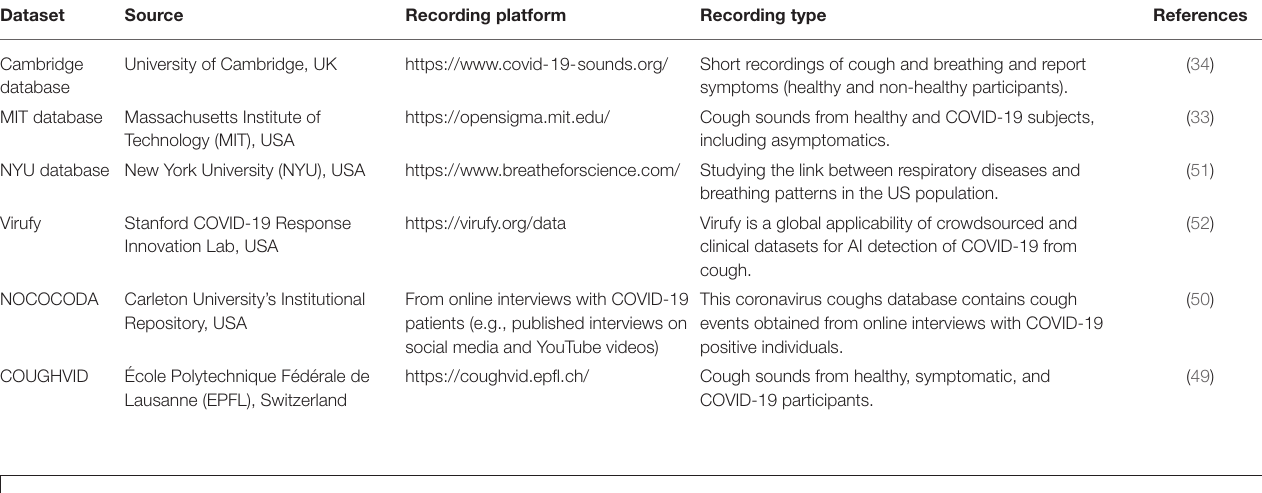
TABLE 1 | A list of some online recording platform-based cough databases.